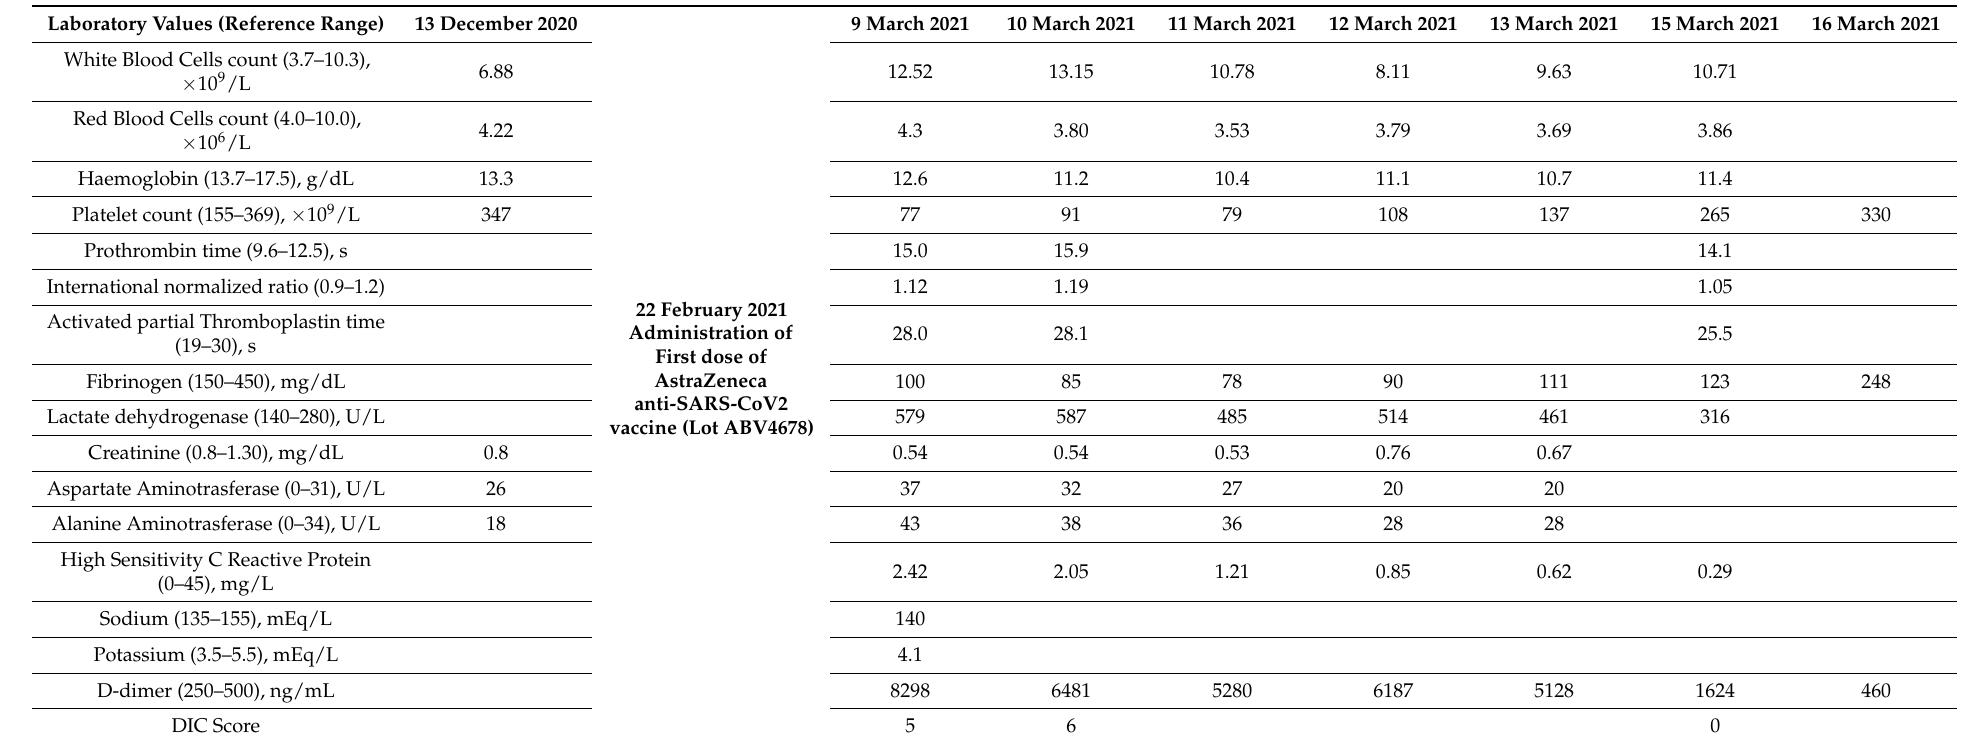
Table 2. Summary of Patient Laboratory Data Related to Disseminated Intravascular